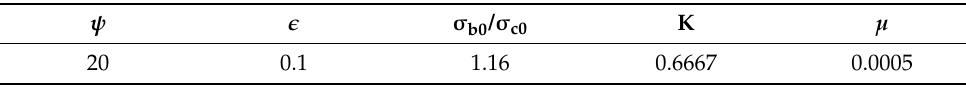
Table 3. Parameters of concrete damaged plasticity